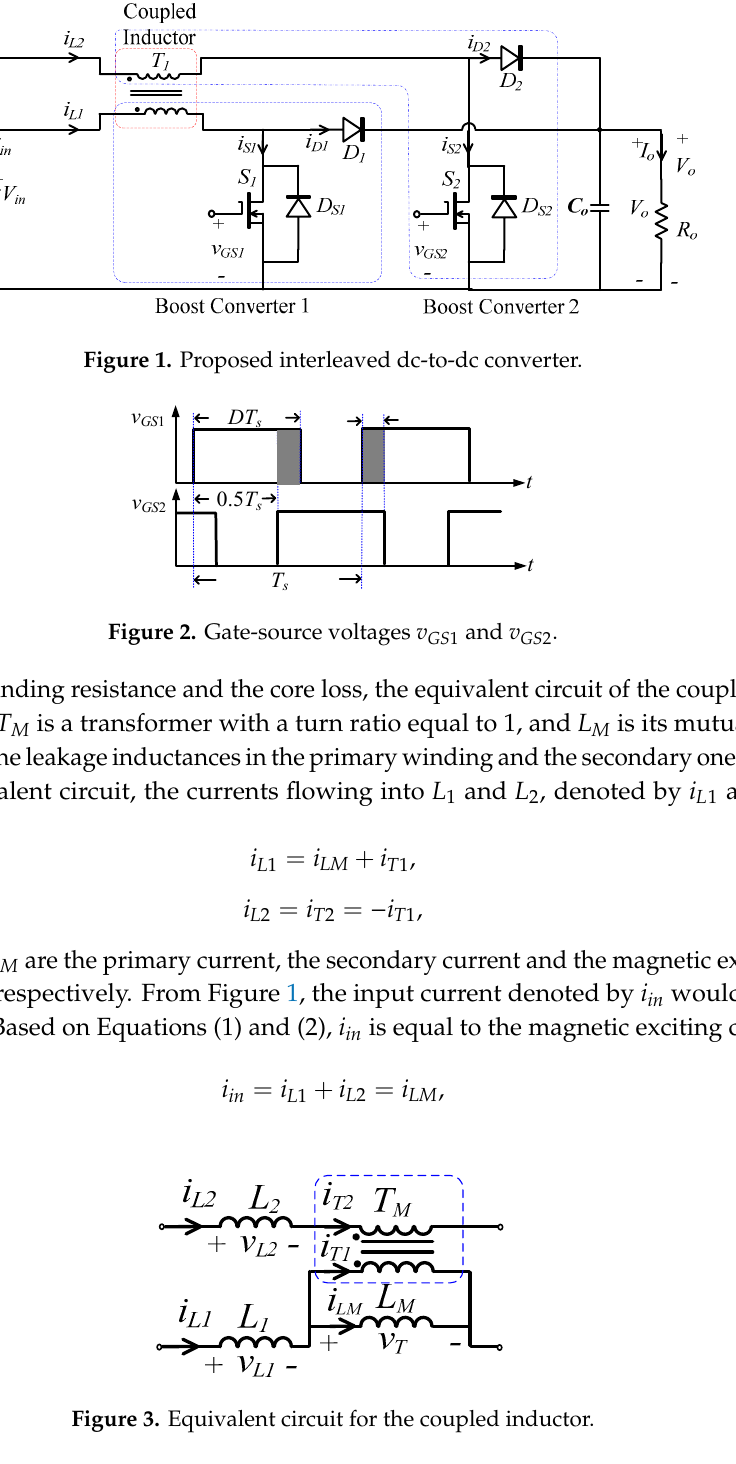
Figure 1. Proposed interleaved dc-to-dc converter.